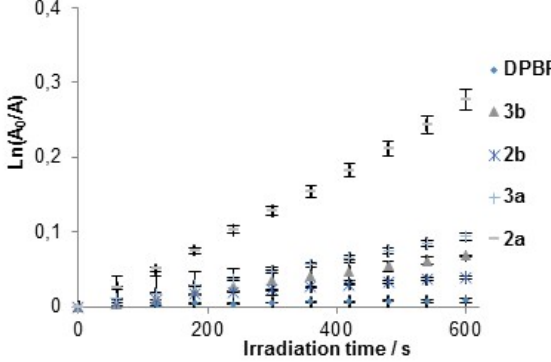
Figure 4 - Time dependent photodecomposition of DPBF (50 mM) photosensitized by corroles derivatives 2a,b and 3a,b in DMF upon irradiation with a LED array with an emission peak centred at 640 nm and a bandwidth at half maximum of ± 20 nm (9.0 mW cm −2 ) with or without PS (0.5